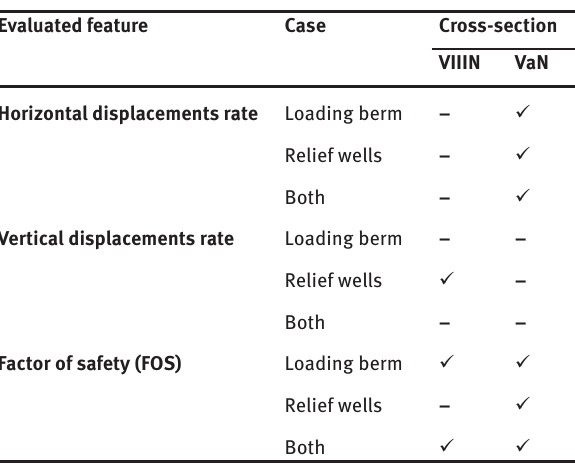
Table 4: Summary of the preventive measures effectiveness with regard to safety of the dam. Evaluated